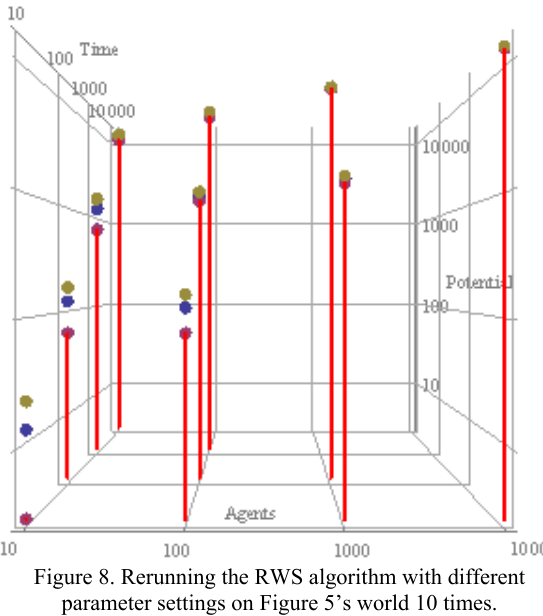
Table 3. Outputs on different parameter setups on a 10 length